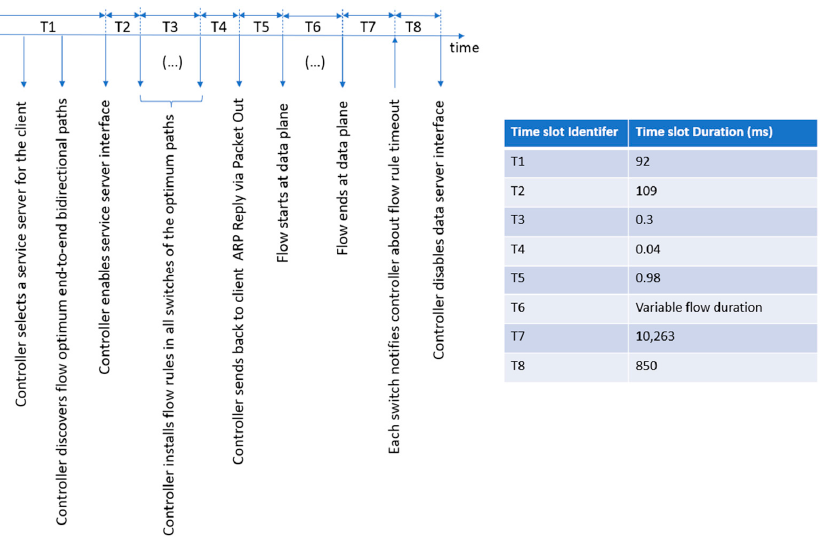
Figure 10. The temporal line of system actions associated with the novel automatic (de)activation of the edge server network interface using a proactive flow controller together, along with the measured time slots (in ms) between the most relevant system actions.